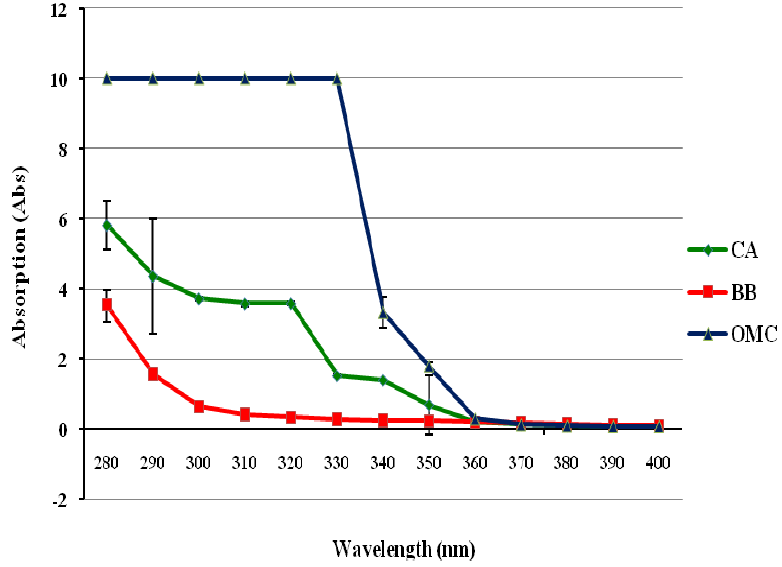
Figure 5. The protection effect of Centella extract (CA), bearberry extract (BB) and octyl methoxy cinnamate (OMC) against UVA (ultraviolet-A) and UVB (ultraviolet-B) damage at different concentration; (a) at 0.1%, (b) at 1.0% and (c) at 10.0%. The 10% Centella extract shows comparable results with